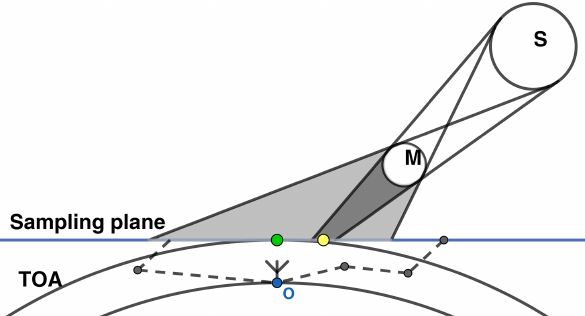
Figure 1. Schematic illustration of a solar eclipse, including umbral (dark gray) and penumbral (light gray) shadow and the definition of sampling plane and top of atmosphere (TOA). S denotes the Sun, M the Moon and O the observer. The green dot marks the point in the sampling plane located vertically above the observer. The yel- low dot represents the intersection of the observer–Sun line with the sampling plane. The dashed lines show exemplary photon paths. In the atmospheric part, the solar angle is assumed to be constant, at- mospheric refraction is